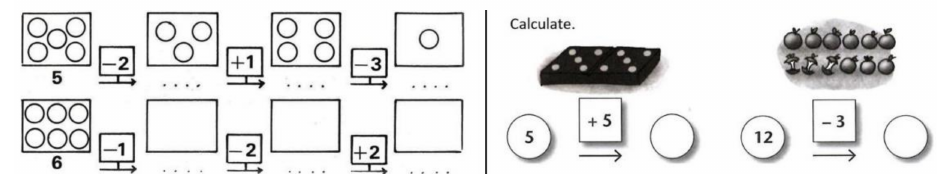
Figure 10. Arrow language in R&W (1980s, left, Grade 1, student book 1–3, p. 50) and PP3 (2010s, right, Grade 1, student book 7–8, p.